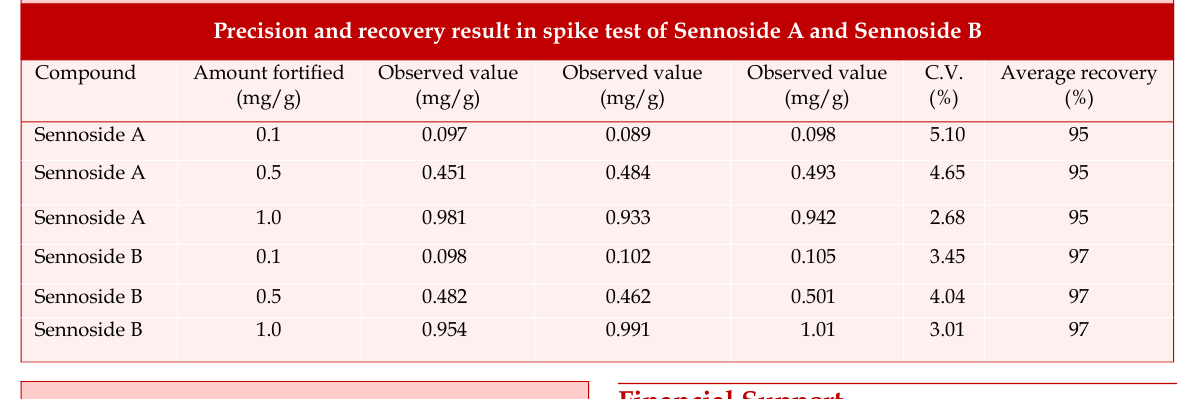
Precision and recovery result in spike test of Sennoside A and Sennoside B